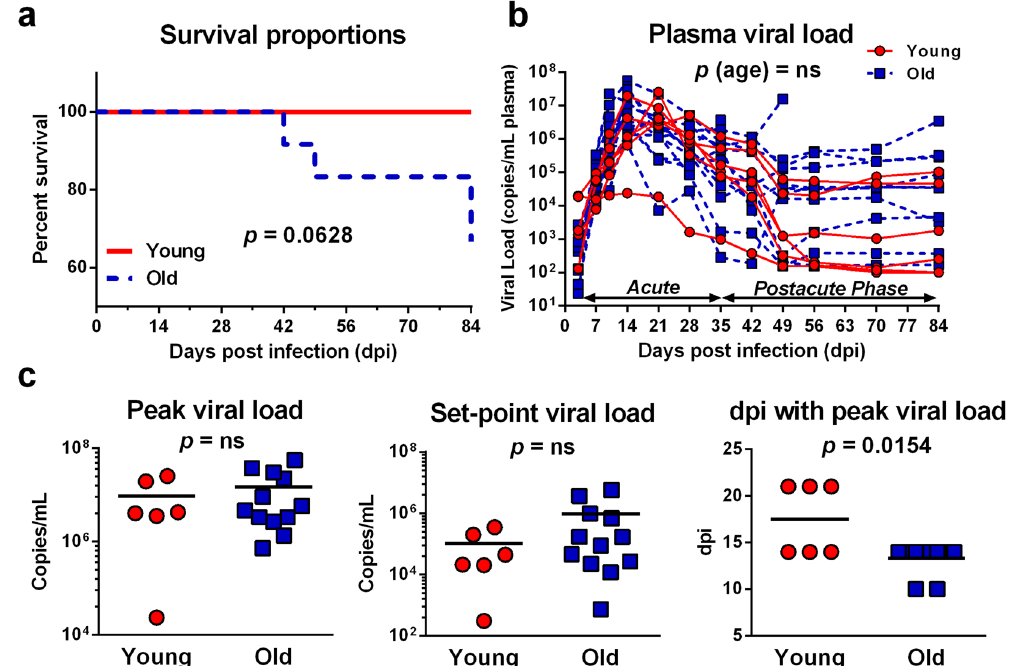
Figure 1. Disease status of young and old ChRM during early SIV infection. ( a ) Kaplan–Meier survival curve comparing SIVmac239-infected young macaques (n = 6, red solid line) with old macaques (n = 12, blue dashed line) during the 84 days after infection. The P value is given by the log rank (Mantel–Cox) test. ( b ) Plasma viral loads are expressed as SIV RNA copies/ml and are shown for every animal in the young (red circle) and old (blue square) groups. The data are shown as the mean ± SEM. The comparison between the two groups was performed by using two-way ANOVA. ( c ) Peak and set-point levels of viral load and days with peak viral load were compared between the young and old macaques. P values were determined by using the Mann-Whitney